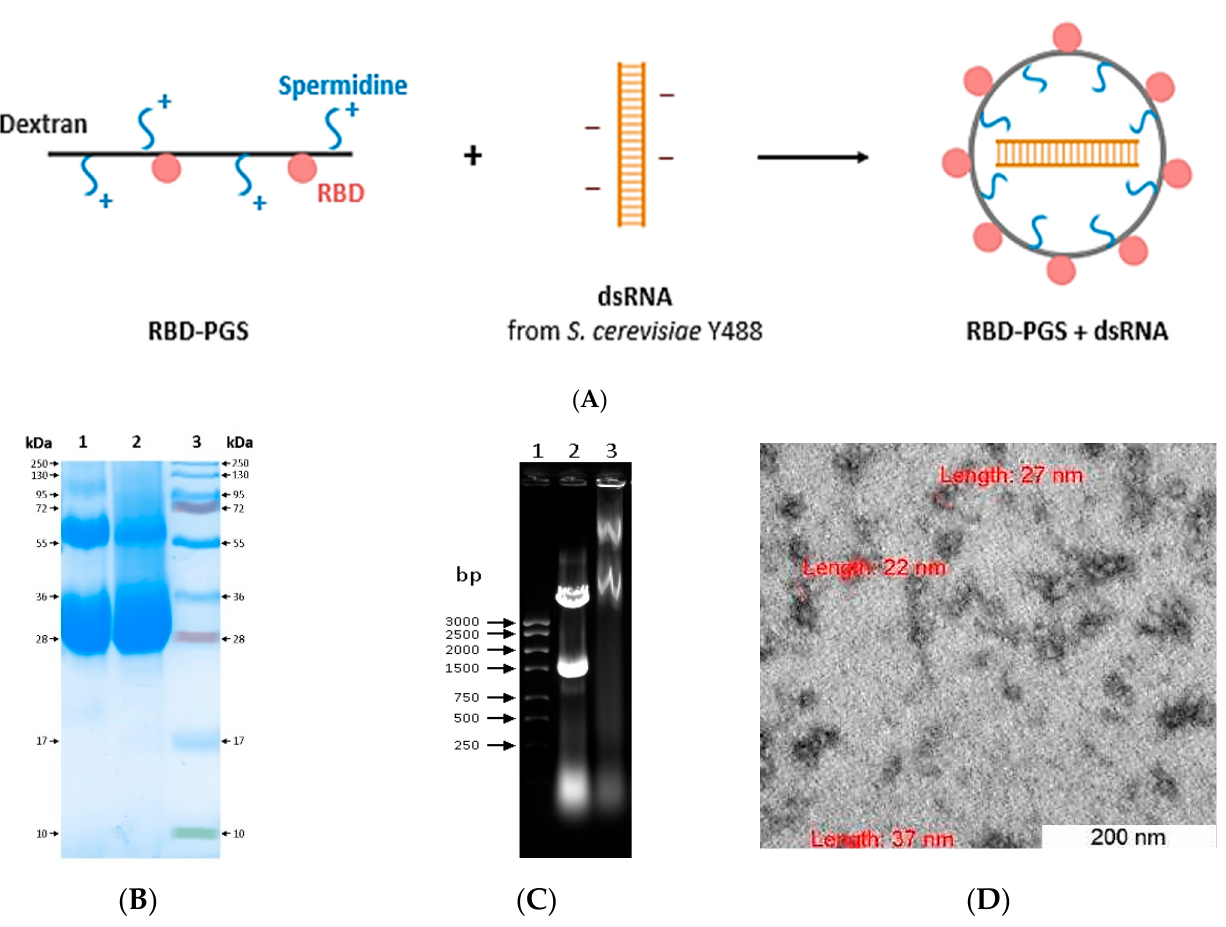
Figure 1. ( A ) The scheme for obtaining an RBD conjugate with polyglucin-spermidine complex and dsRNA. ( B ) Electrophoresis of RBD-PGS conjugate in 15% PAAG: (1) RBD protein, 40 µg; (2) RBD-PGS conjugate, 40 µg; and (3) molecular weight markers, 10–250 kDa. ( C ) Electrophoresis in 1% agarose gel: (1) molecular weight markers; (2) intact dsRNA; and (3) RBD-PGS + dsRNA particles. ( D ) An electron micrograph of RBD-PGS + dsRNA